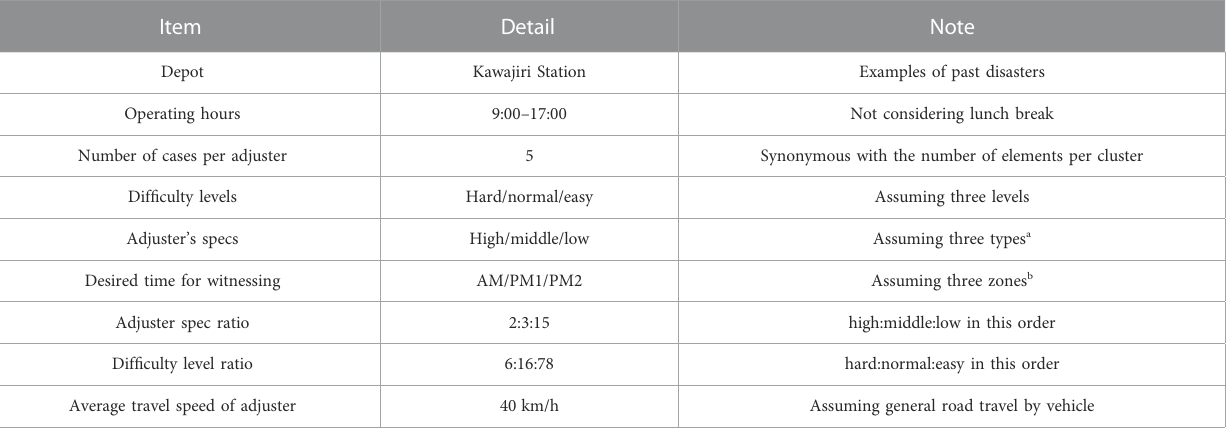
TABLE 1 Common settings for each instance.